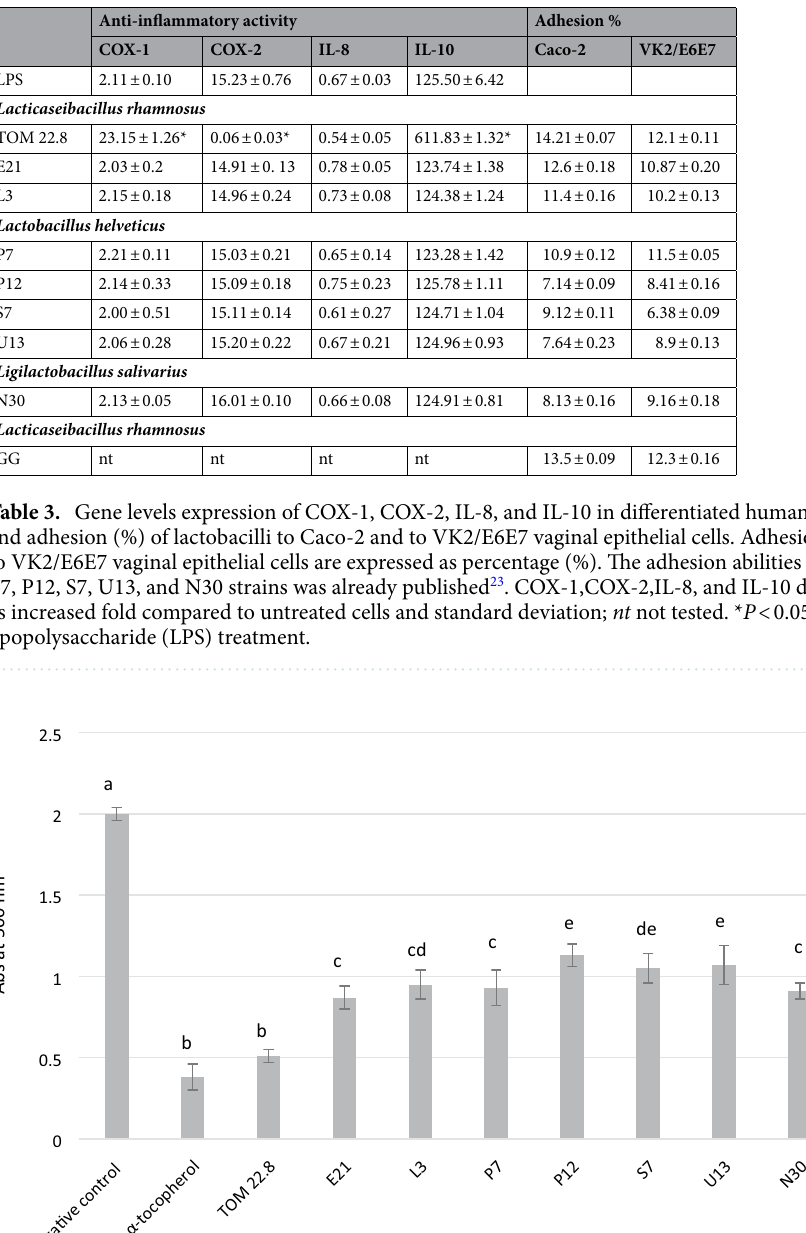
22.8 encapsulated strain was detected showing cell density of 10 log cfu/g after 18 months of storage (data not shown). Demographic and clinical findings of patients recruited in the pilot study. Overall, 30 women, aged between 18 and 45 years (mean age of 36.73 ± 5.96 years), satisfying the inclusion and exclusion criteria, were enrolled in the pilot study. The demographic and clinical characteristics of the enrolled patients are shown in Table 4. Participants’ self-reported signs or symptoms during the whole study are shown in Supplementary Fig. S1 online. At the baseline evaluation, all the examined women (100%) reported leucorrhoea and subjective vulvar discomfort, while mild symptoms of burning and itching were reported in 50% and 43% of cases, respectively.